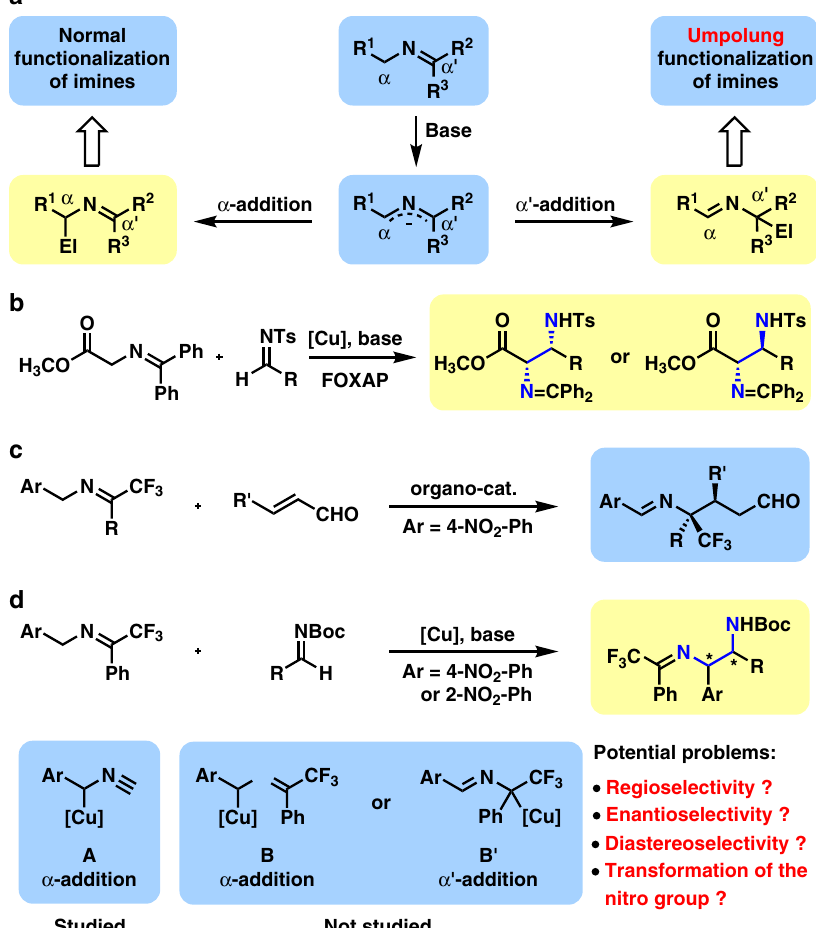
Fig. 1 Prior arts and our work in the catalytic asymmetric reactions with 2-azaallyl anions. a Regioselectivity in the nucleophilic addition of 2-azaallyl anions. b Reported catalytic asymmetric α -addition by Hou and Wu. c Reported catalytic asymmetric α ′ -addition (umpolung addition) by Deng. d Our work: synthesis of 1,2-diamines through copper(I)-catalyzed α